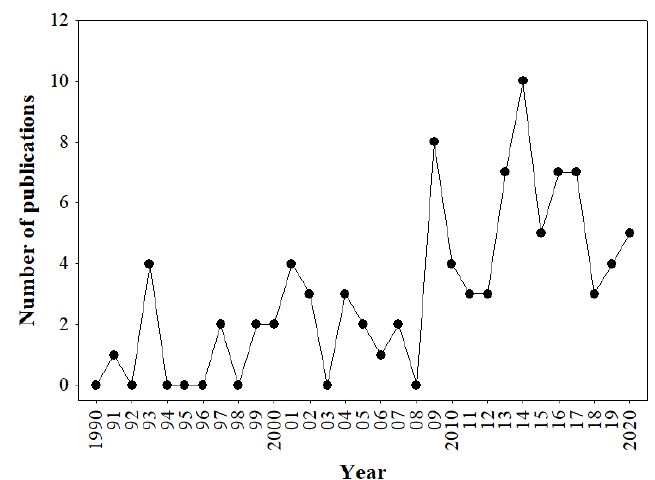
Figure 3. Number of publications per year of invertebrate’s studies from the upper Parana river